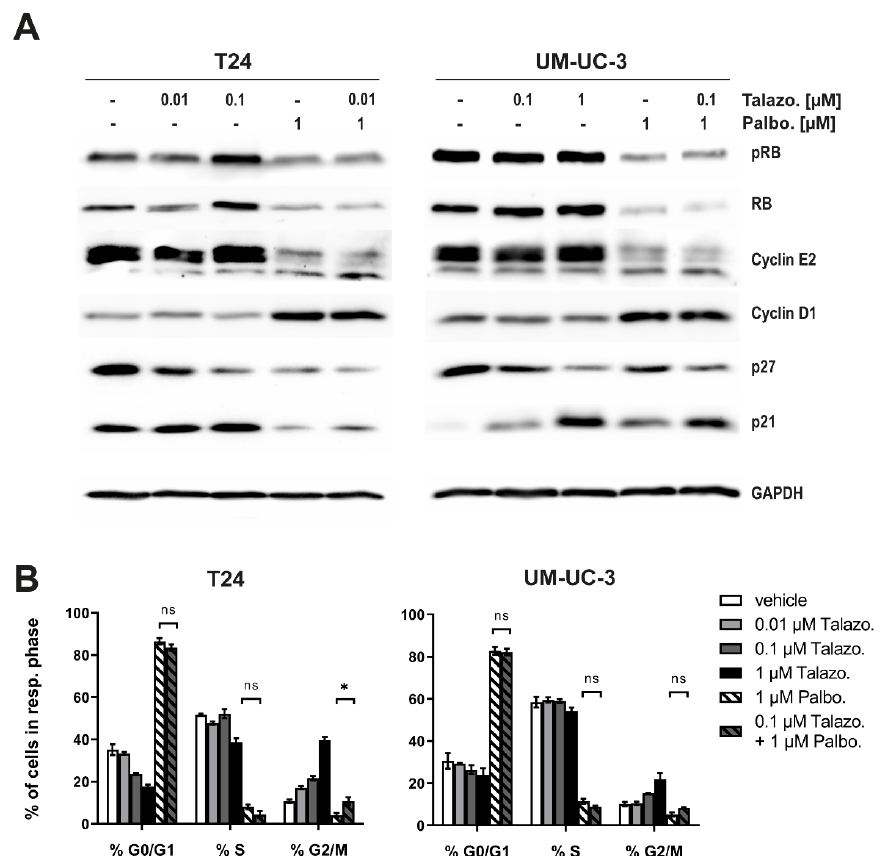
Figure 6. The Talazoparib/Palbociclib combination therapy induces both a G0/G1 and a G2 cell cycle arrest in BLCA cells. ( A ) Key proteins of cell cycle transition were quantified via Western blot analysis 96 h after treatment. ( B ) Analysis of subpopulations for each cell cycle phase 24 h after treatment via flow cytometry after EdU incorporation and staining with 7-AAD. Raw data were analyzed using FlowJo V10 software and are presented as mean ± SD of biological triplicates. Statistical comparison was performed using t -test of GraphPad Prism V9 software, indicating respective p -values: ns: p > 0.05, and *: p ≤